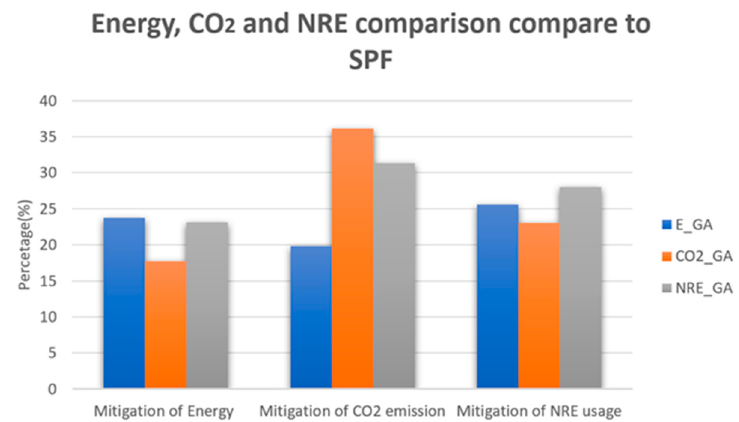
Figure 7. Comparison between three algorithms.